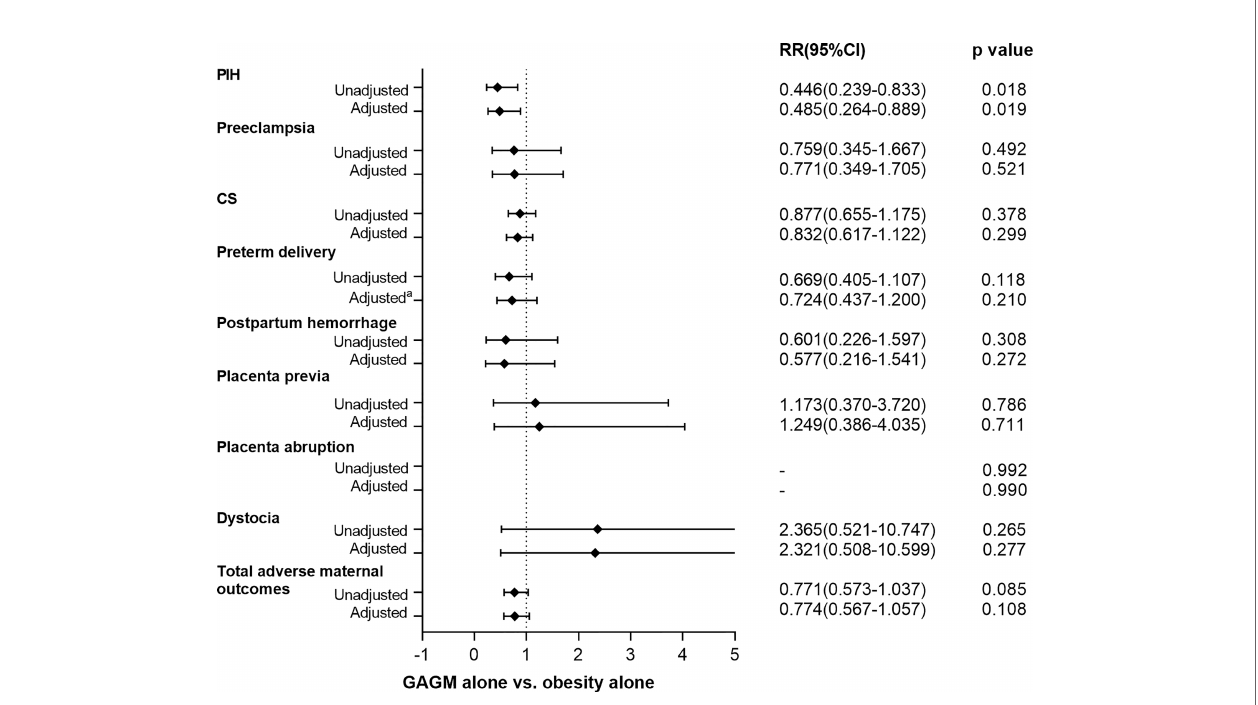
FIGURE 1 | Comparison of adverse maternal outcomes between pre-pregnancy obesity alone and GAGM alone. Adjusted: adjusted for maternal age, gestational age, and primiparity. Adjusted a : adjusted for maternal age, and primiparity.